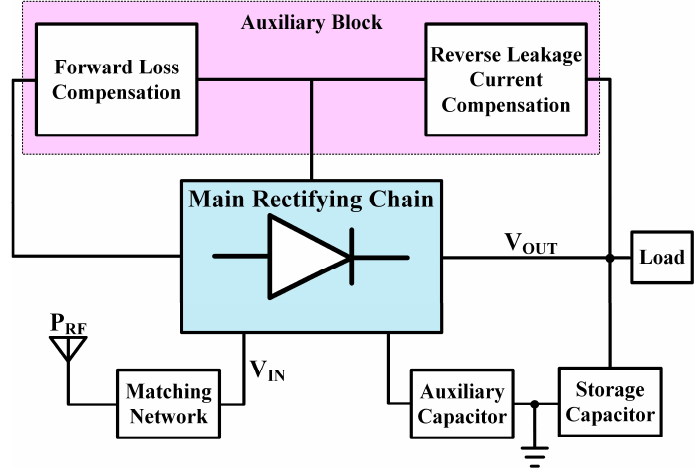
Figure 3. Block diagram of the proposed reconfigurable Radio Frequency to Direct Current (RF–DC) converter scheme.